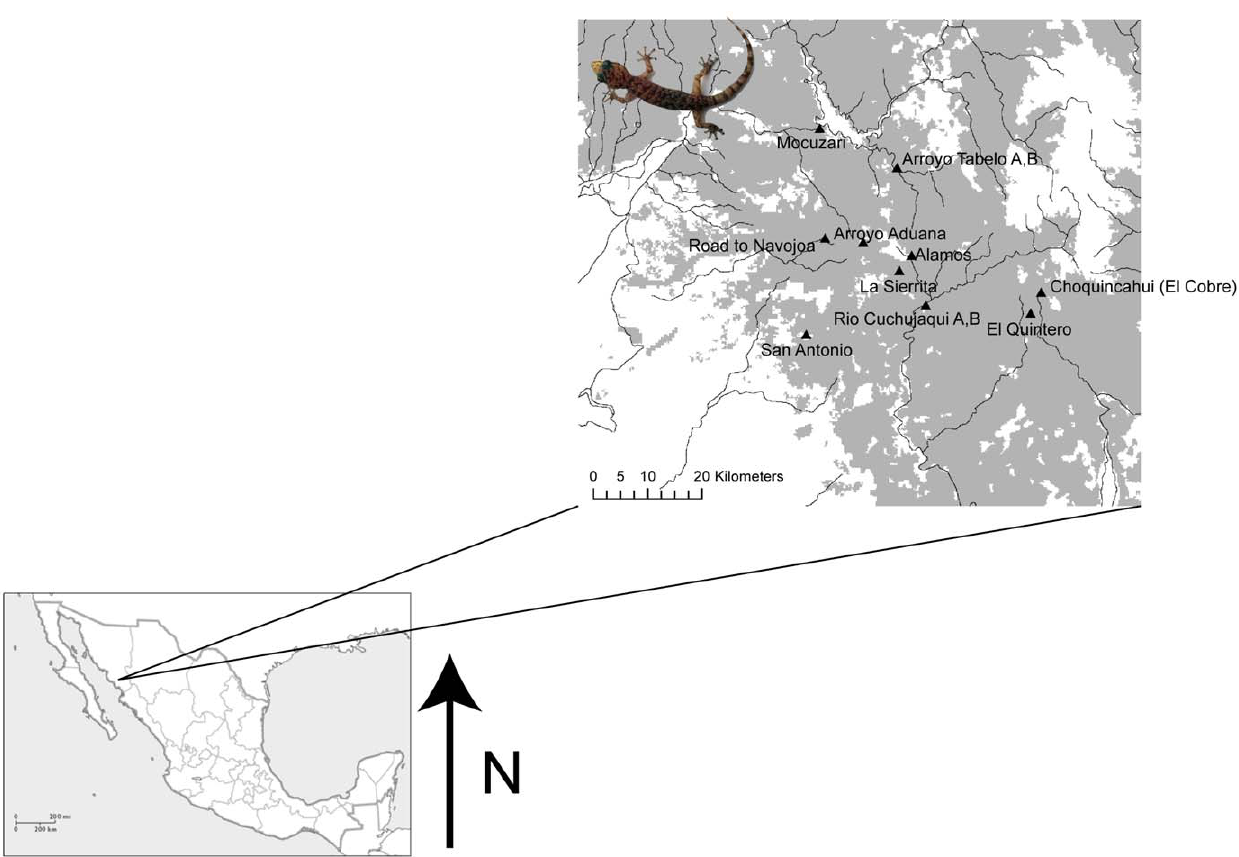
Figure 1. Sampling sites for all individuals and populations of Phyllodactylustuberculosus included in this study. Darker shades of gray represent tropical dry forest. Dark lines represent rivers, streams and arroyos sampled throughout the study area.